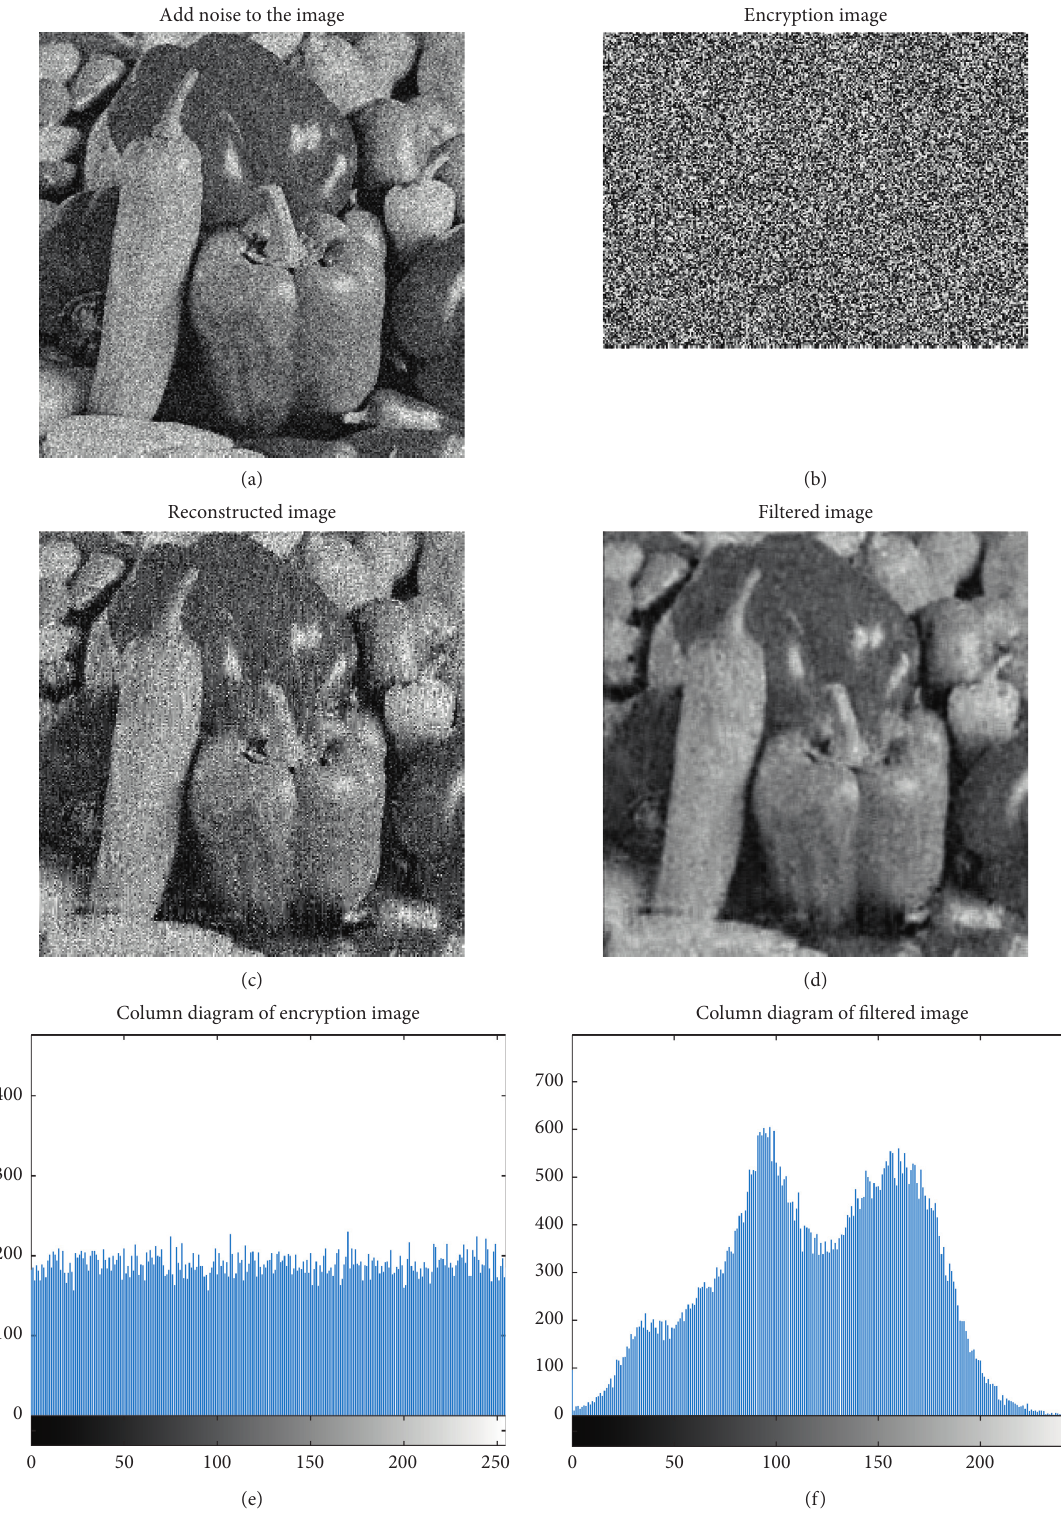
Figure 9: Encryption and reconstruction of noisy images: (a) image with noise, (b) cipher image, (c) reconstructed image, (d) filtered image, (e) histogram of cipher text image, and (f) histogram of filtered